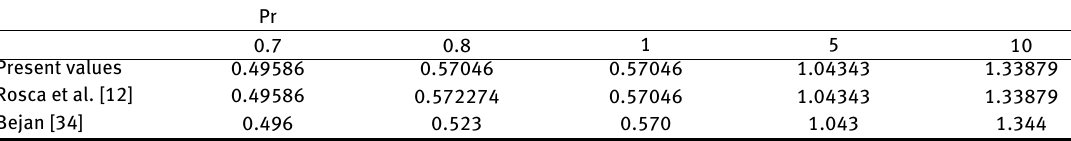
Table 1: The comparison values of − θ (cid:48) (0) for different values of Pr when n = 1 , p = 0 and β = λ = σ = 0